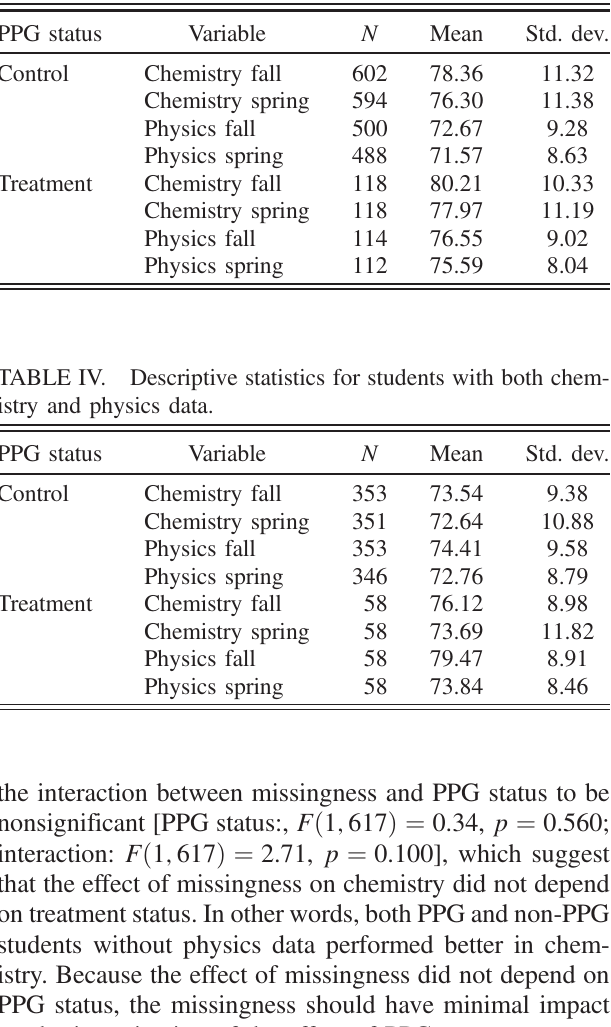
TABLE III. Descriptive statistics for all chemistry and physics data.